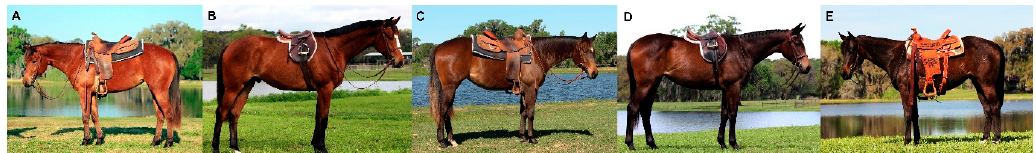
Figure 1. American Quarter Horses illustrating the diversity in shade of bay coat colour, quantified as a ranking within the 129 sampled individuals. The bay shade rank number for each horse is ( A ) 3, ( B ) 27, ( C ) 64, and ( D ) 101 and ( E ) 120.